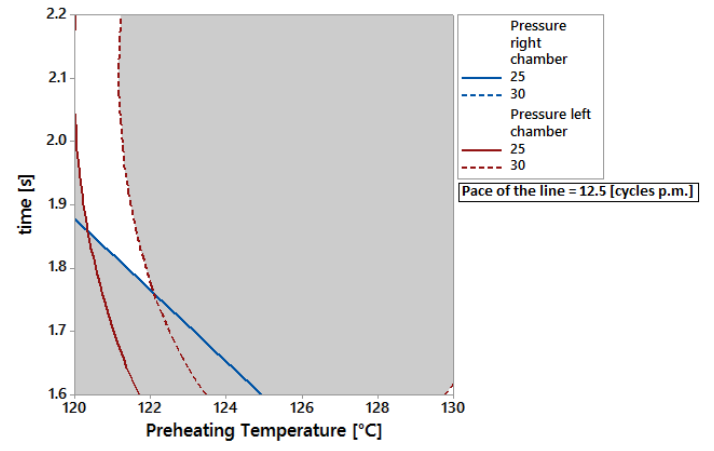
Figure 15 – Overlaid contour plot of Pressure of right chamber and left chamber vs. Time and Preheating temperature. Interval of response from 25% to